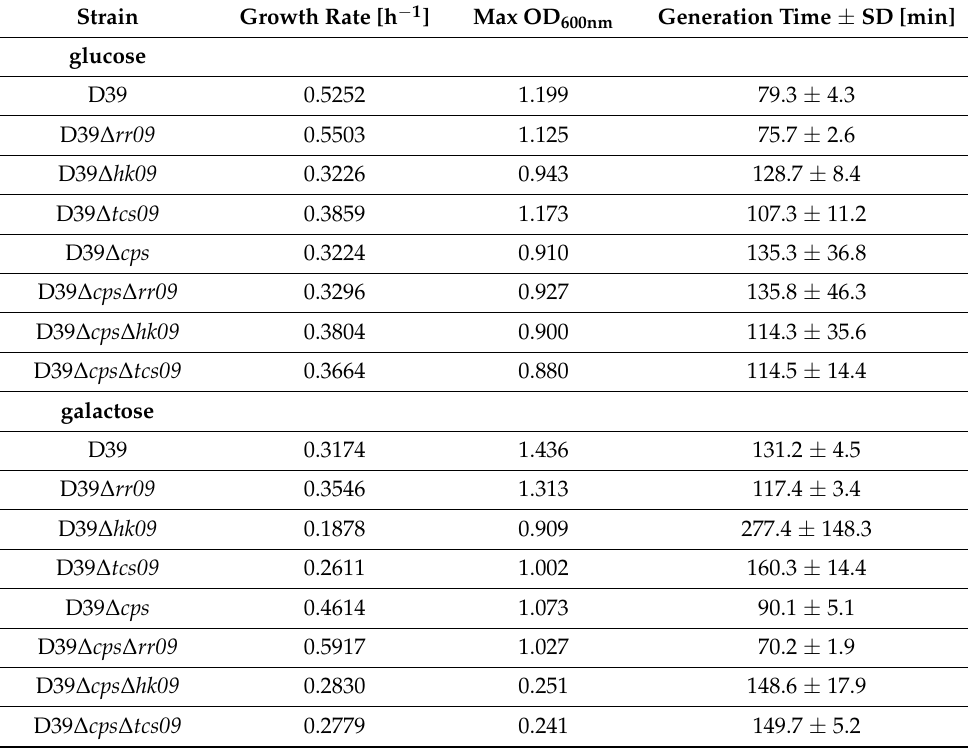
Table 5. Characteristic growth parameters of strains D39, D39 ∆ cps , and isogenic